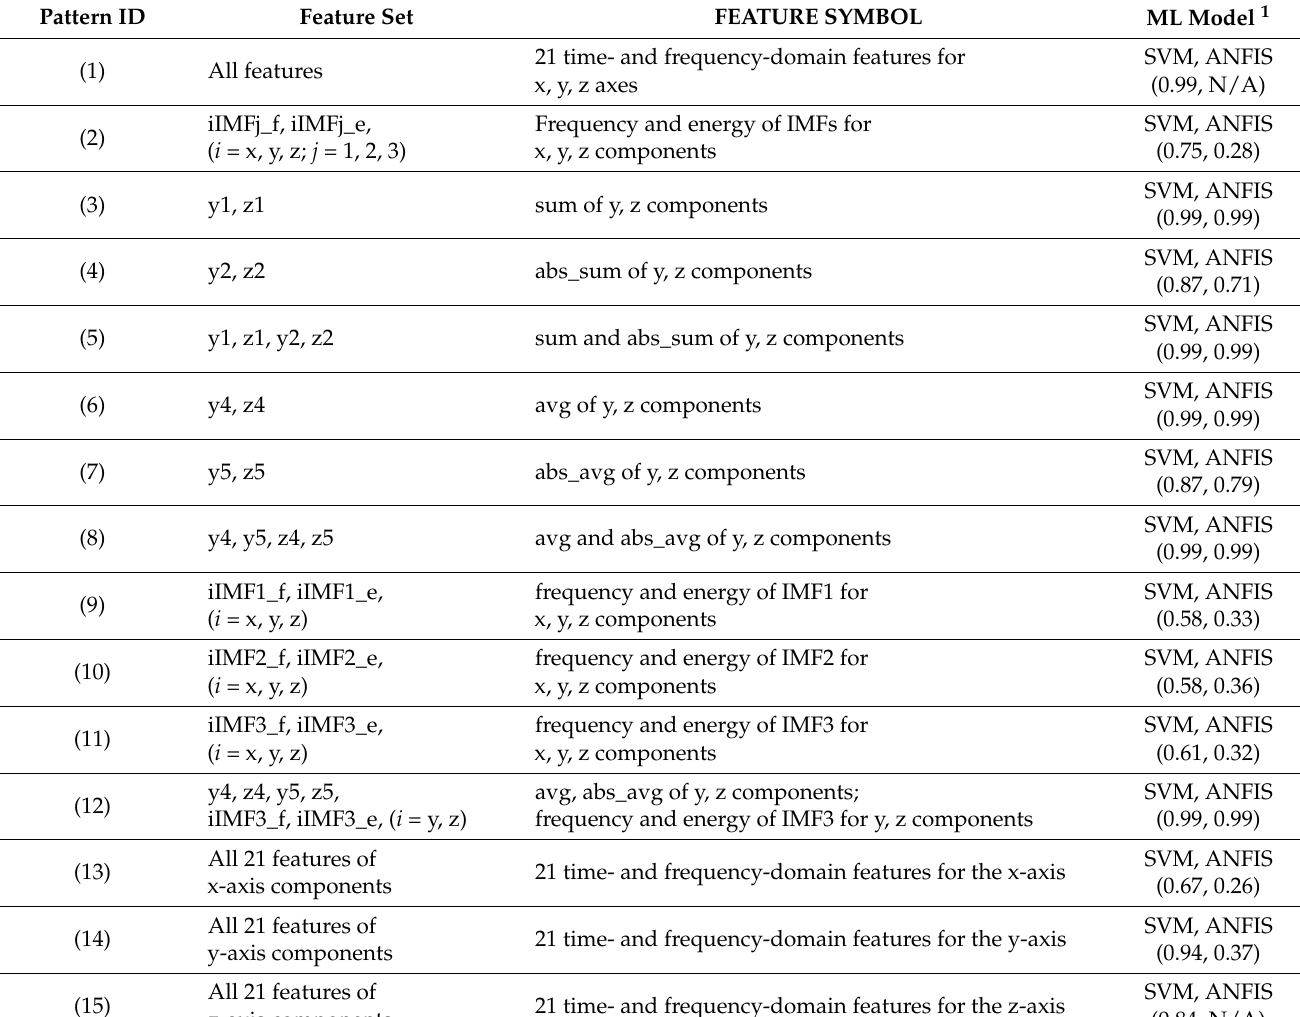
Table 5. Definition of the feature patterns and accuracies of the trained models with five-fold